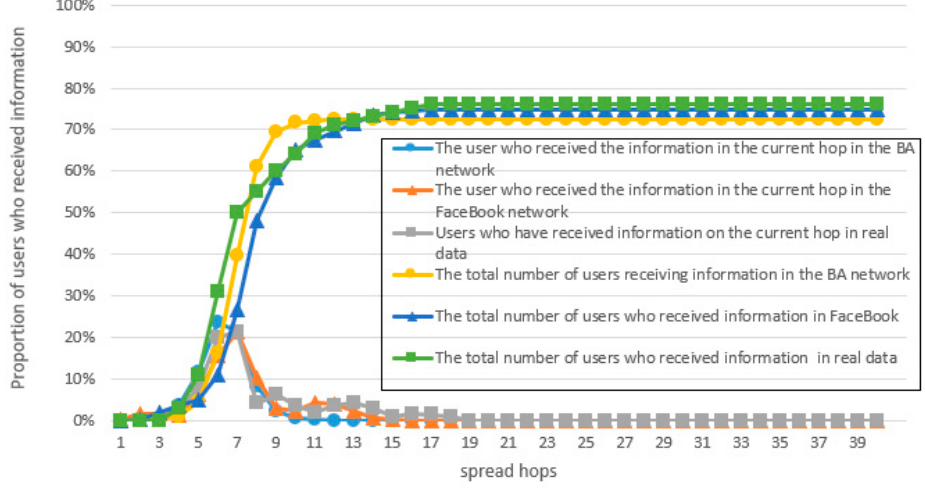
Figure 14. Dissemination of the privacy information of a medium popular user between simulated data and real data.